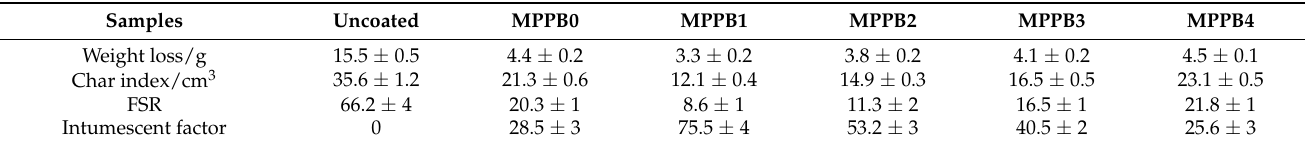
Table 4. Fire-resistant performance of the coatings obtained from the cabinet method and tunnel method tests. Samples Uncoated MPPB0 Weight loss/g